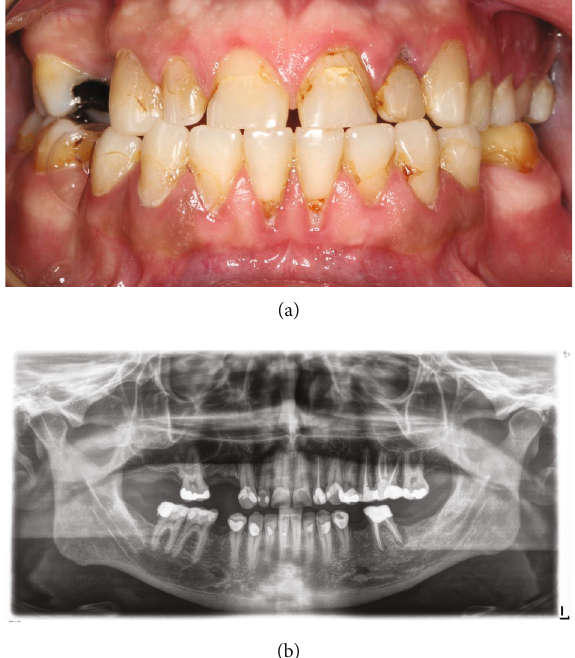
Figure 1: (a) Intraoral frontal view of the patient teeth preoperatively. (b) Panoramic X-ray view of the patient teeth preoperatively.